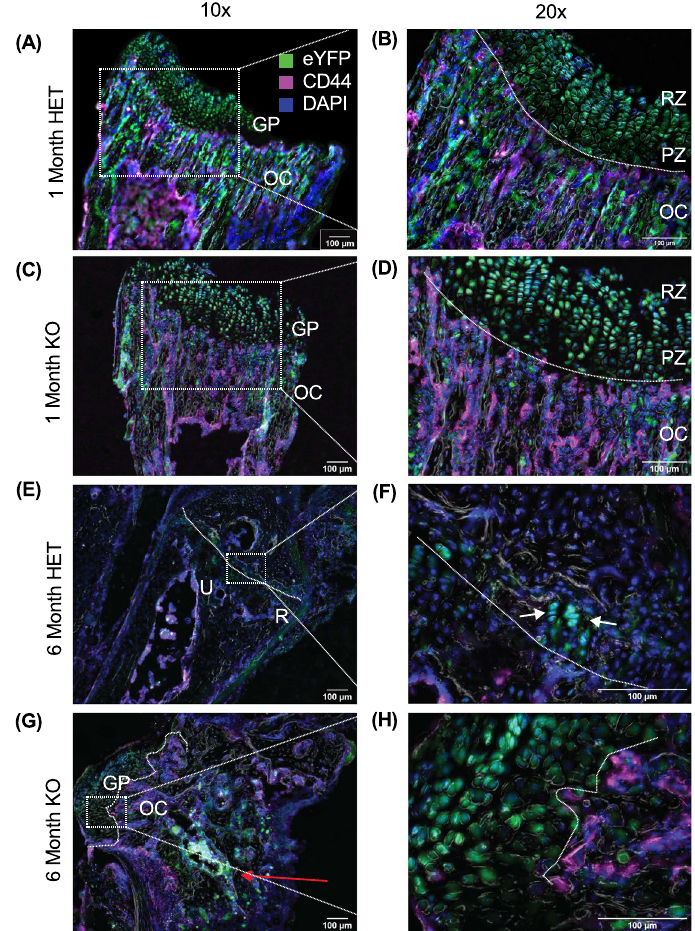
Figure 4. The growth plates of adolescent and adult KO mice contain YFP + cells in wrist tumors. ( A – D ) Representative images of the distal forelimb from adolescent 1-month-old Het ( A , B ) and KO ( C , D ) animals. ( E – H ) Representative images from the same region taken from adult 6-month-old Het ( E , F ) and KO ( G , H ) animals. Low power shown in the left column (×10; scale bar 100 μm) with a high power inset (×20; scale bar 50 μm) marked by white dotted square and white dotted lines is shown in the right column. Additional white dotted lines indicate chondro-osseous junction where the ossification center (OC) is identified by CD44 + cells. The proliferative zone (PZ) of the growth plate (GP) contains the columnar chondrocytes whereas the resting zone (RZ) contains the round resting chondrocytes. GP Grow Plate, Green eYFP, Blue DAPI, magenta CD44, gray Phase Contrast. Forelimbs from n = 3 (6 total bones) animals were examined for each genotype at each